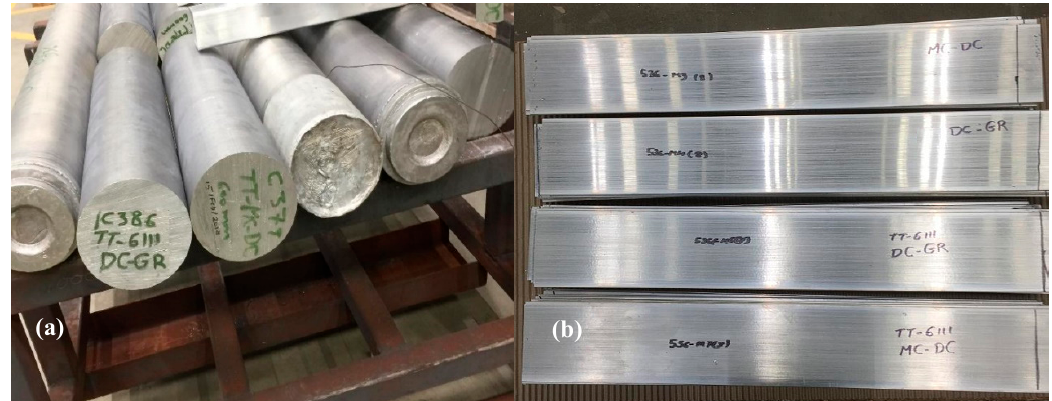
Figure 2. ( a ) DC, DC-GR and MC-DC Billets of TT-6111 alloy, and ( b ) Extruded flat bars produced from billets of TT-6111 alloy.